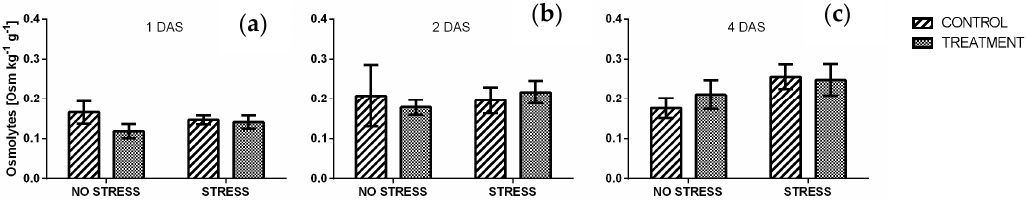
Figure 11. Osmolytes concentration in rocket leaves treated with water (CONTROL) and with borage extract (TREATMENT) and subjected to salt stress (200 mM). Measures were taken after one day ( a ), two days ( b ) , and four days ( c ) of stress. Values are means ± SE ( n = 4). Data were subjected to two-way ANOVA. Different letters, where present, represent significant differences ( p < 0.05).